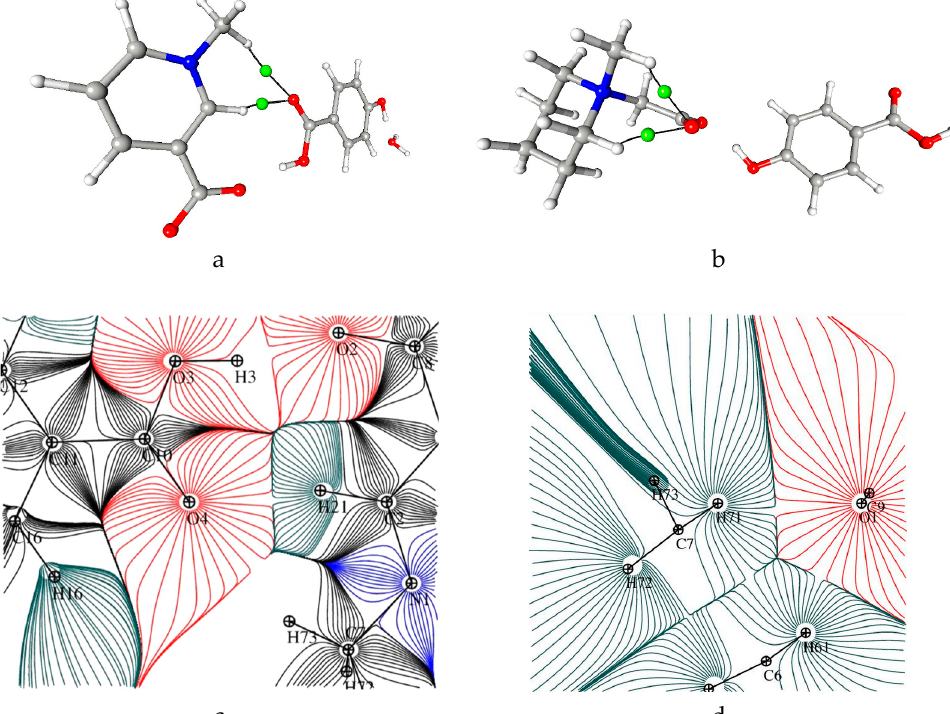
Figure 11. Bond path and associated critical point for C-H···O intermolecular hydrogen bonds in 1 ( a ) and intramolecular hydrogen bonds in 2 ( b ) . Representation of C7-H73···O4 ( c ) and C7-H71···O1 ( d ) hydrogen bonds in total static density gradient maps.